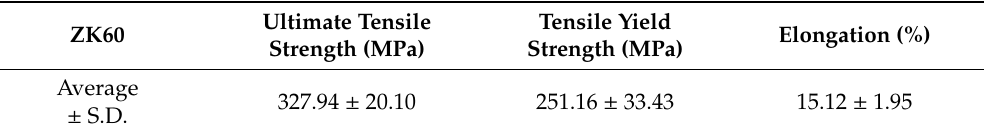
Table 2. Improved mechanical properties of ZK60.